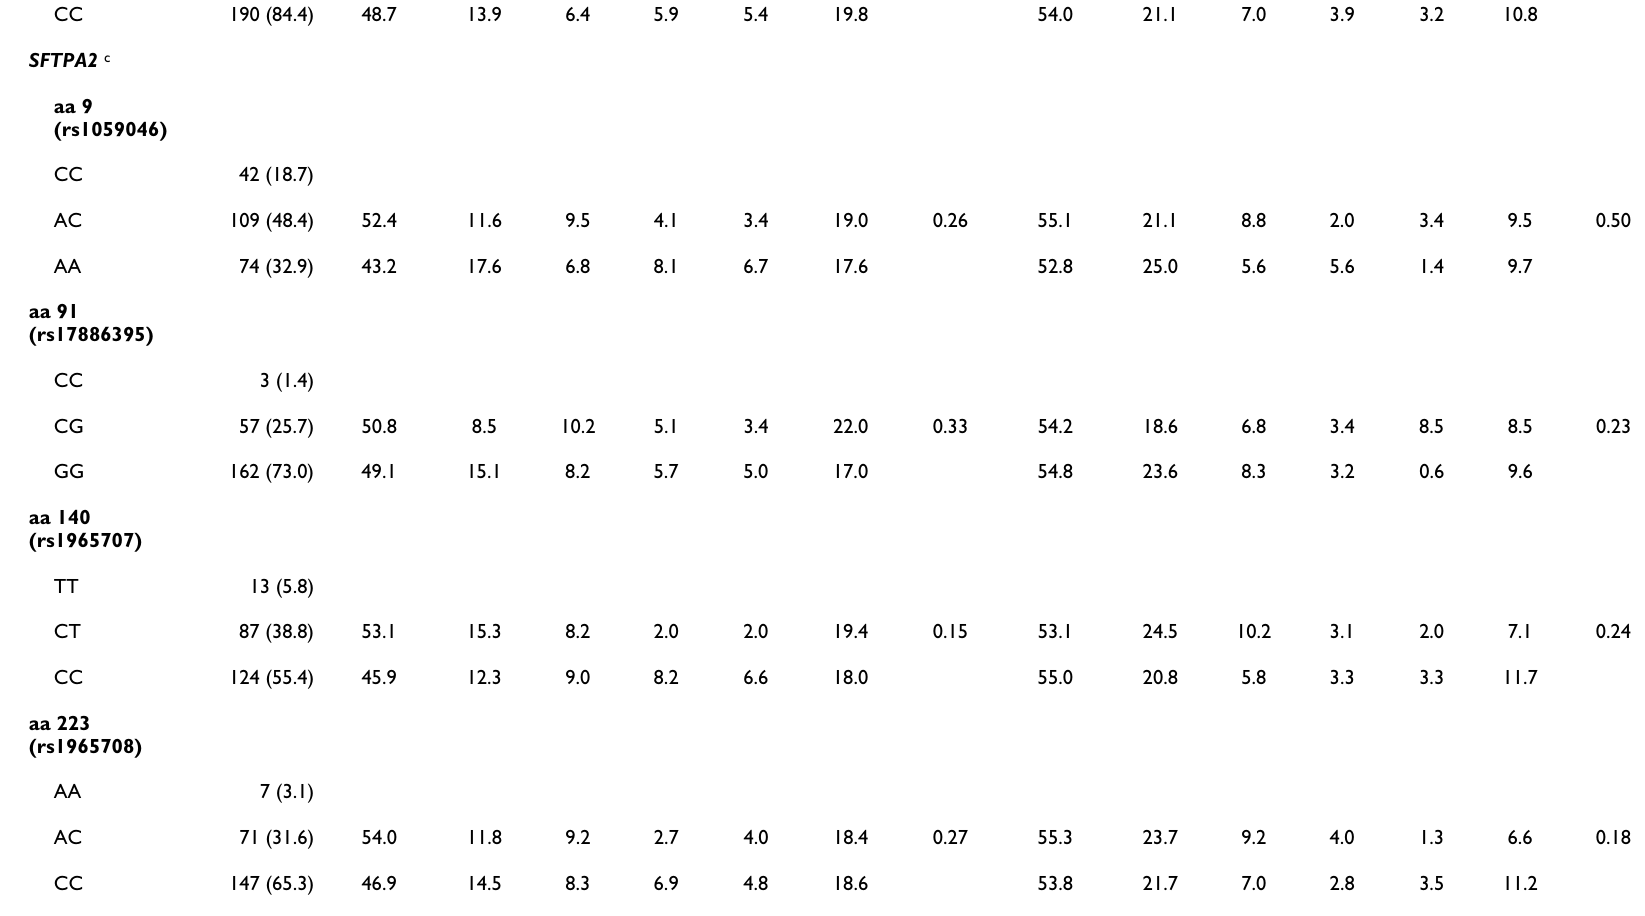
Table 2: Unadjusted associations between SNPs from surfactant protein A alleles ( SFTPA1 , SFTPA2 ) and respiratory symptoms a during the first year of life for white infants at risk for developing asthma. (CT and MA, 1998 – 2000)